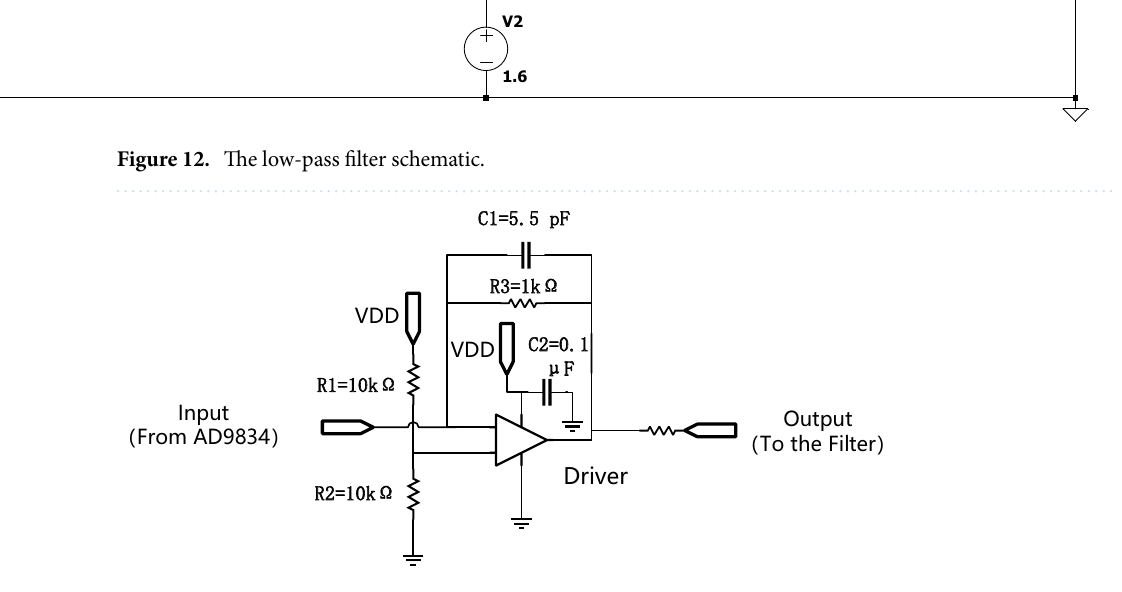
Figure 13. The driver